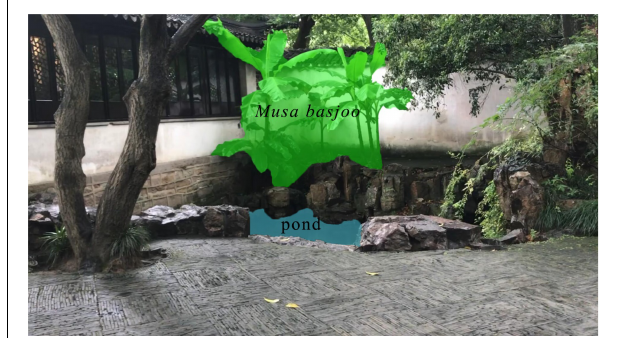
FIGURE 4 | The two areas of interest (AOI) of the video scenery in this experiment are divided into ranges. Green area for the Musa basjoo , blue area for the pond, with the remaining part of the scene being background.